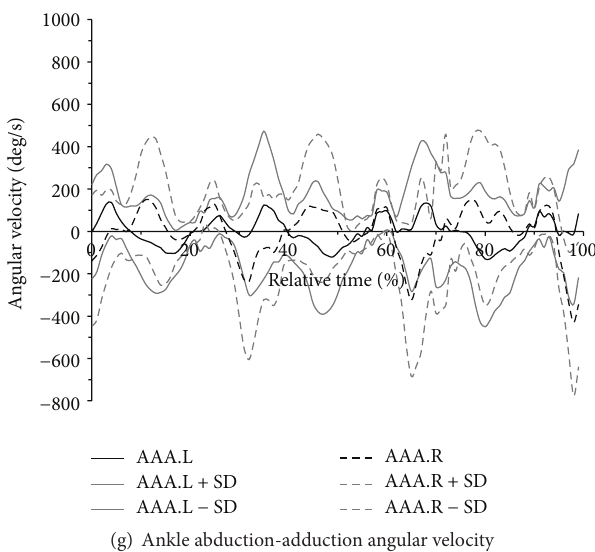
Figure 3: Instantaneous changes in the angular velocity in the area of lower limb joints with respect to specific axes during a 30-meter sprint acceleration phase along a straight line for the left limb (continuous line) and right limb (dashed line). Continuous or dashed thin grey lines were denoted ± SD for the left and right limb, respectively.